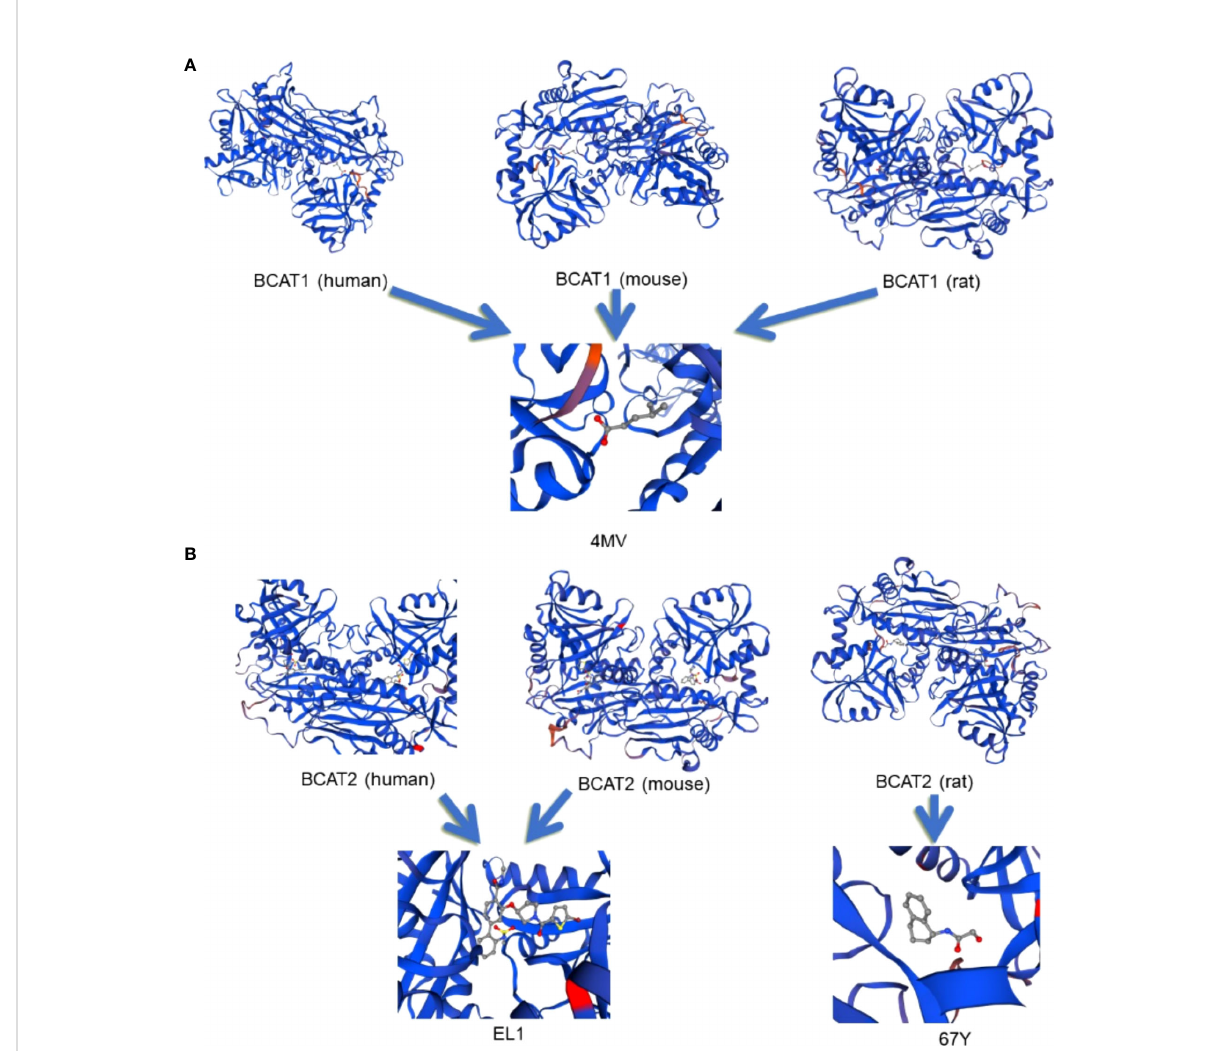
FIGURE 1 The molecular structures of different types of BCAT protein sequences. Panel (A) shows the folded structures of human, rat and mouse BCAT 1 respectively, and their ligand maps, all of which depend on and bind to the cofactor PLP, and the binding ligands are all 4-METHYL VALERIC ACID (4MV). Panel (B) shows the folded structures of human, rat, and mouse BCAT2, respectively. Among them, the ligand that binds to human and mouse BCAT2 is 3-({(3R)-1-[(5-bromothiophen-2-yl)carbonyl]pyrrolidin-3-yl}oxy) -N-methyl-2 ’ -[(methylsulfonyl)amino]biphenyl-4- carboxamide (EL1), and the ligand is shown in the fi gure. The ligand that binds to rat BCAT2 is 2-hydroxy-N-[(1R)-1,2,3,4-tetrahydronaphthalen- 1-yl]acetamide (67Y), and the ligand is shown in the fi gure. All the structural diagrams are drawn on the mapping software SWISS-MODEL. The protein sequence of BCAT is input on the software to export the structural